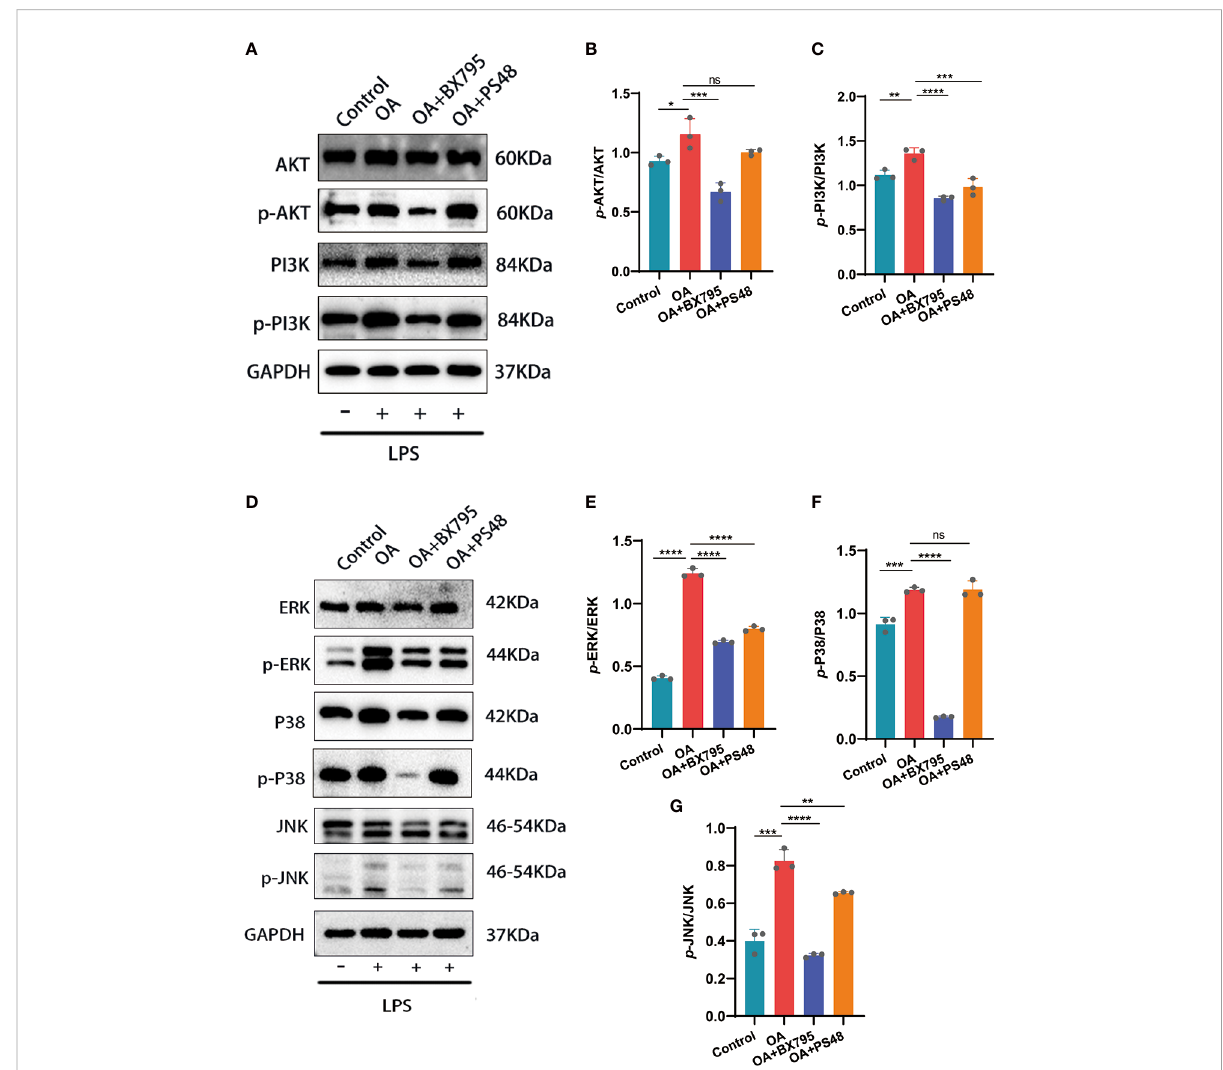
FIGURE 7 Western blot and quantitative analysis of the effects on MAPK and PI3K/AKT signaling pathways after targeted PDK1 downregulation. (A-C) Protein levels of mediators related to the PI3K/AKT signaling pathway by Western blot and quanti fi cation analysis. B: quanti fi cation analysis of p -AKT/AKT; C: quanti fi cation analysis of p -PI3K/PI3K. (D-G) Western blot and quanti fi cation analysis for the protein levels of MAPK signaling pathway mediators. E, F, and G: quantitative analysis of p -ERK/ERK, p -p38/p38, and p -JNK/JNK, respectively. Values are presented as means ± SD (n =3). * p < 0.05; ** p <0.01; *** p < 0.001; **** p < 0.0001; ns, no signi fi cance, relative to the OA group. OA, osteoarthritis; SD, standard